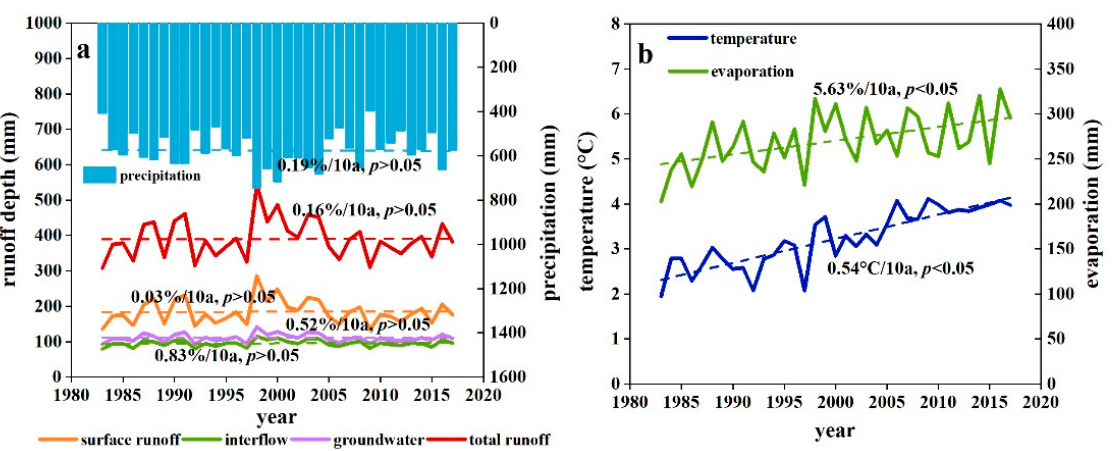
Figure 5. Temporal variations in ( a ) annual precipitation and total runoff and runoff components; and ( b ) and temperature and evaporation.